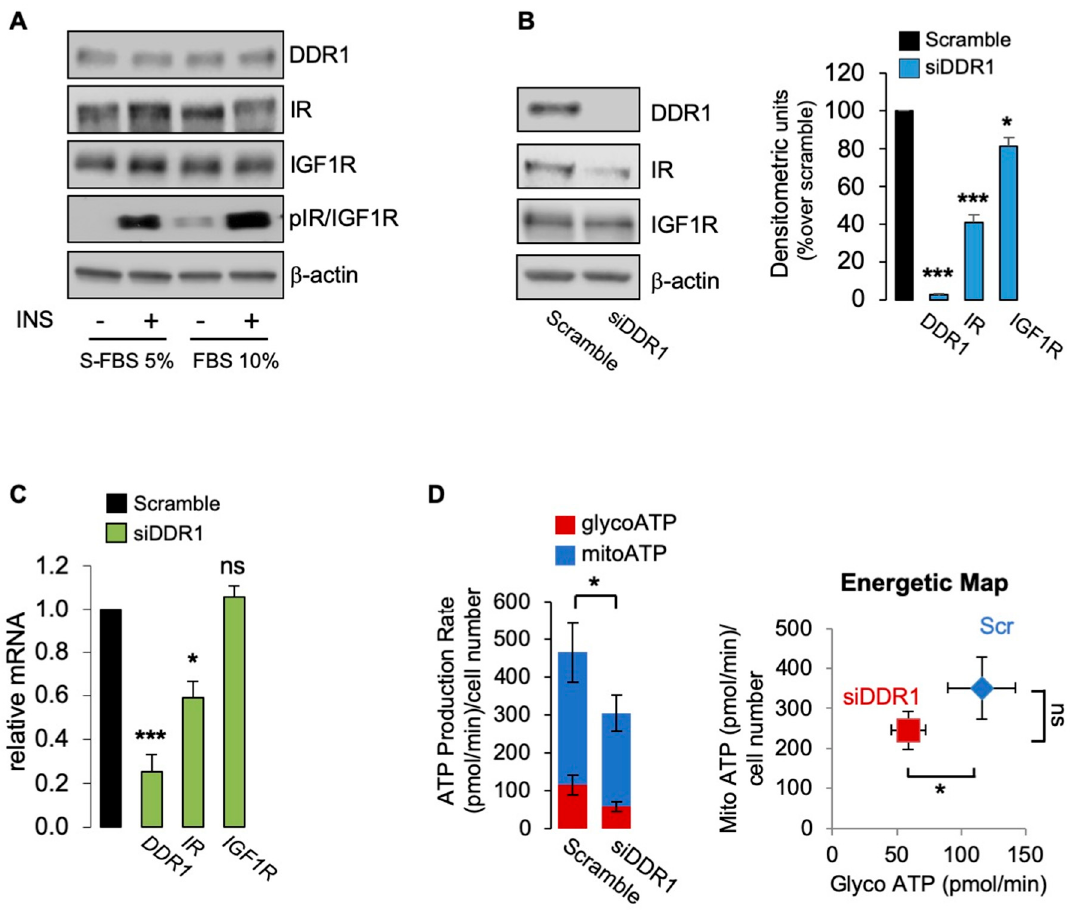
Figure 6. ( A ) MCF7 cells grown in 5% charcoal stripped fetal bovine serum (S-FBS) and in 10% FBS were stimulated with vehicle (-) or insulin (10 nM for 5 min), and IR/IGF1R phosphorylation evaluated by Western blotting analysis using anti-phospho-(p)IGF1R (Tyr1135/1136)/pIR (Tyr1150/1151) antibody. β -actin was used as control for protein loading. Blots are representative of three independent experiments. The histograms represent the mean ± SEM of densitometric analysis of three independent experiments; ( B ) MCF7 cells cultured in S-FBS were transiently transfected with siRNA to DDR1 or scramble siRNAs. After 48 h, cells were lysed and analyzed by SDS-PAGE and immunoblotted with the indicated primary antibodies. β -actin was used as control for protein loading. Blots are representative of three independent experiments. The histogram represents the mean ± SEM of densitometric analysis of three independent experiments. ( C ) Cells cultures as in ( B ) were analyzed for DDR1, IR, and IGF1R mRNAs expression by qRT-PCR analysis. Normalization was done using human GAPDH as housekeeping control genes. Data are presented as the mean ± SEM (error bars) from three independent experiments; ( D ) ATP production rate in MCF7 cultured in 5% S-FBS silenced for DDR1 and in control cells treated with scramble siRNAs. The presented histogram (left panel) and the energetic map (right panel) show the mean and range from three independent experiments. (ns—not significant; *, p < 0.05; **, p < 0.01; ***, p < 0.001).